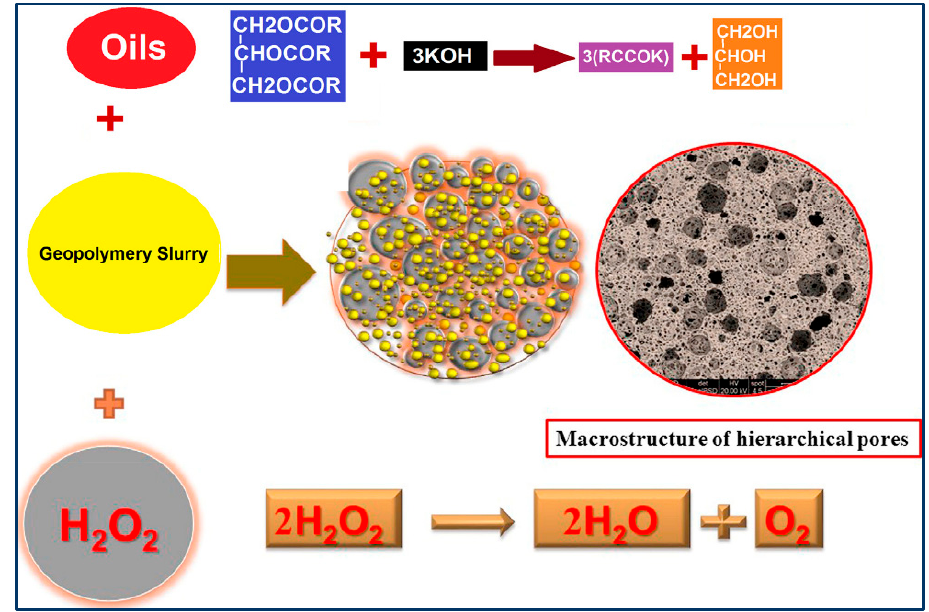
Figure 11. Formation of foamed geopolymers by H 2 O 2 and surfactant [6].